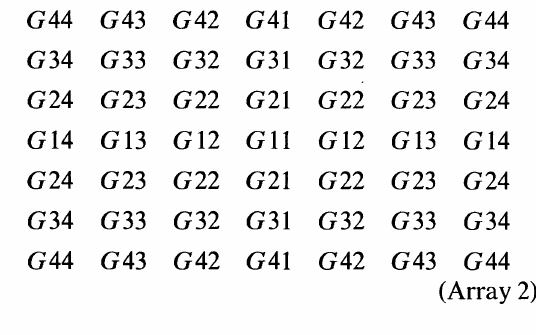
The time convolution calculating